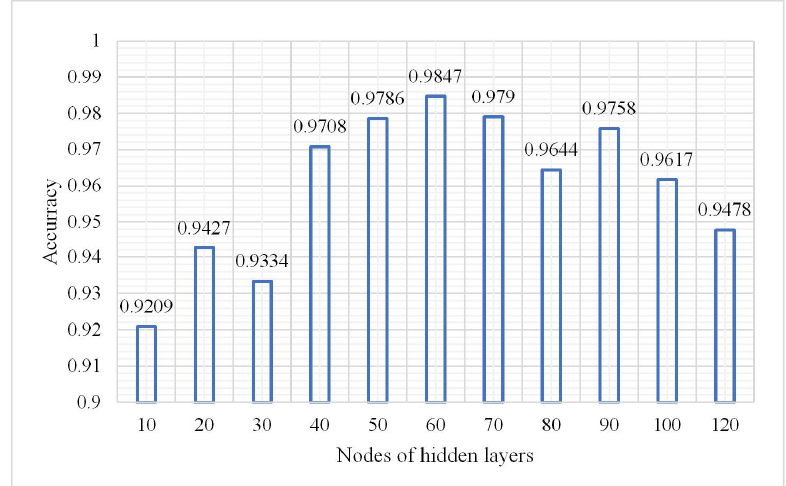
Figure 8. Change in overall accuracy.